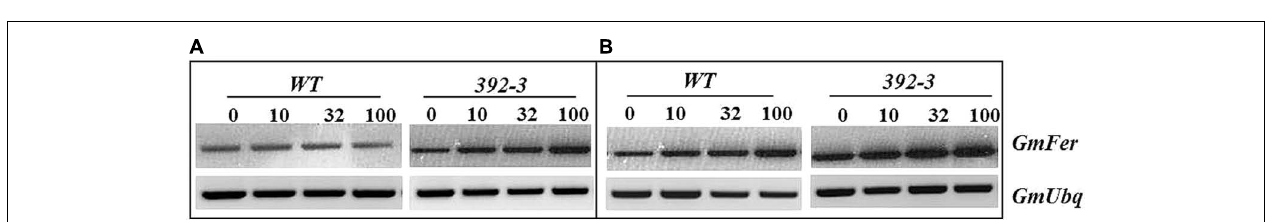
was calculated according to internal 18S RNA expression for each tissue. RNA was extracted from 2 plants for each tissue and Quantitative RT-PCR reaction was repeated three times.